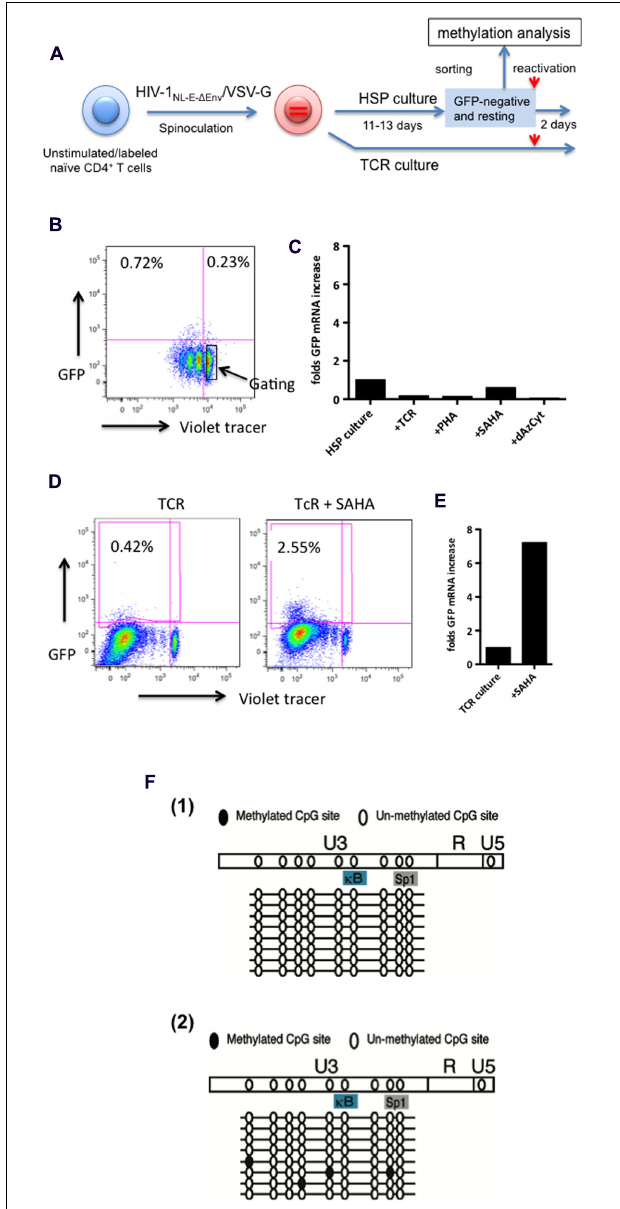
FIGURE 5 | The HIV-1 provirus is refractory to reactivation in resting, latently infected HSP-cultured CD4 + T cells in spite of lack of extensive LTR methylation. (A) Outline of experimental strategy. Violet tracer-labeled, naïve CD4 + T cells were infected with VSV-G protein pseudotyped HIV-1 NL − E − (cid:49) Env (HIV-1 NL − E − (cid:49) Env /VSV-G) and cultured under HSP or TCR conditions for 11–13 days. GFP-negative, resting cells from the HSP culture (marked in square) were sorted by preparative flow cytometry as shown in the representative dot plots (B) . Sorted cells were subjected to various stimuli for 2 days, lysed and the GFP mRNA subjected to quantitative RT-PCR. Transcripts levels were normalized to endogenous RNase P mRNA levels. (C) In parallel, cells from the TCR culture were treated with SAHA or left without, and were tested for GFP expression by flow cytometry (D) , and for GFP transcript levels by quantitative RT-PCR (E) . Sorted cells as in (B) from three blood donors were subjected to methylation analysis of the LTR region (F) . In two of the three donors, no LTR site was methylated [ F(1) ] while a few sites were methylated in one donor [ F(2)